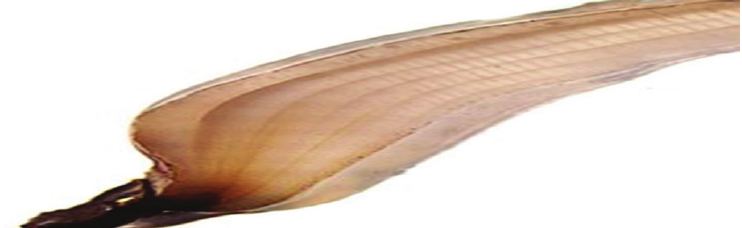
Figure 2. The internal section of S.